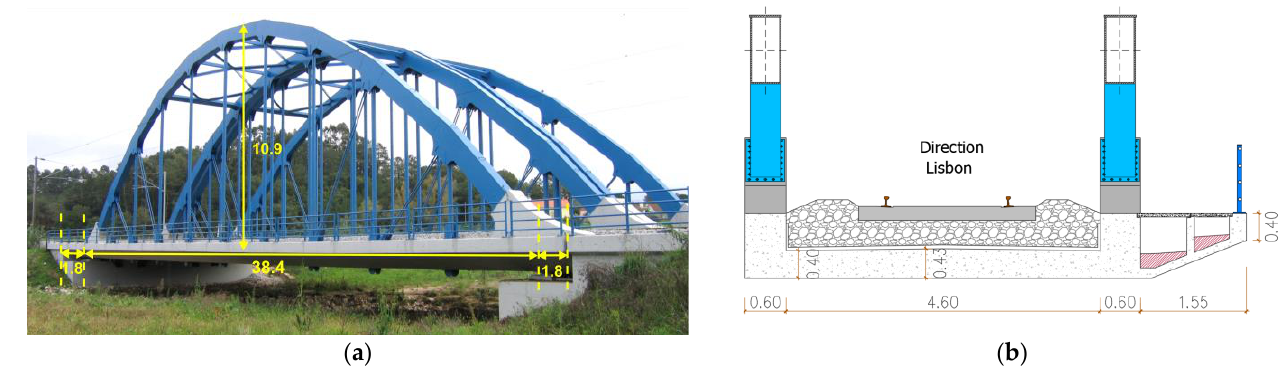
Figure 1. São Lourenço bridge: ( a ) lateral view; ( b ) half-deck cross-section. Figure 1. S ã o Lourenço bridge: ( a ) lateral view; ( b ) half-deck The deck is supported at each abutment by two pot bearings. The distance between the supports is 38.4 m, and the extremities of the deck slab are cantilevers with 1.8 m length. Each half-deck cross-section, with a total width of 7.35 m, consists of a concrete slab laterally supported by two main girders, forming a U-section, and a side footway.